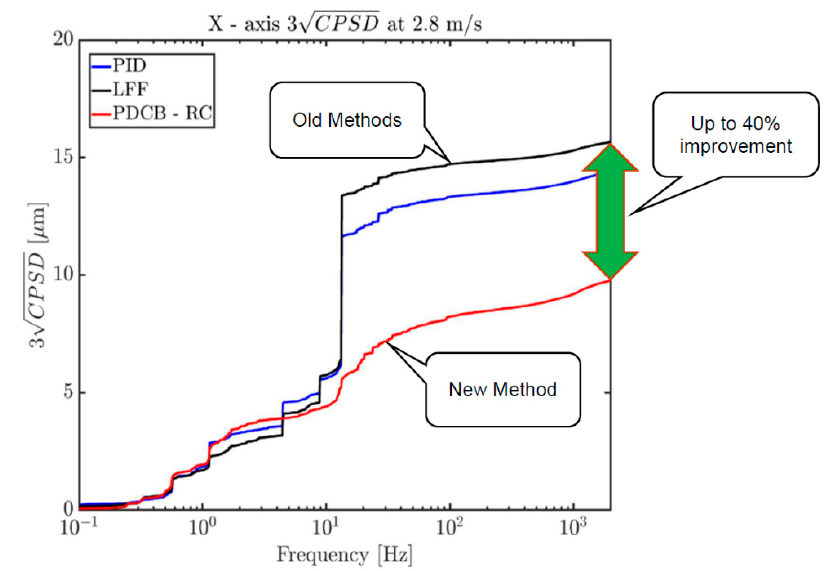
Figure 14. Pilot 1-GSC cumulative power spectral density (CPSD) of tracking error, 40% improvement based on repetitive control. Table 1. BB implementation on selected pilots. Y—BB was implemented.